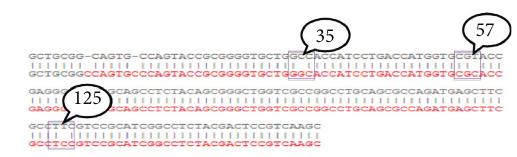
Figure 5: Position of the mutation in the UCP2